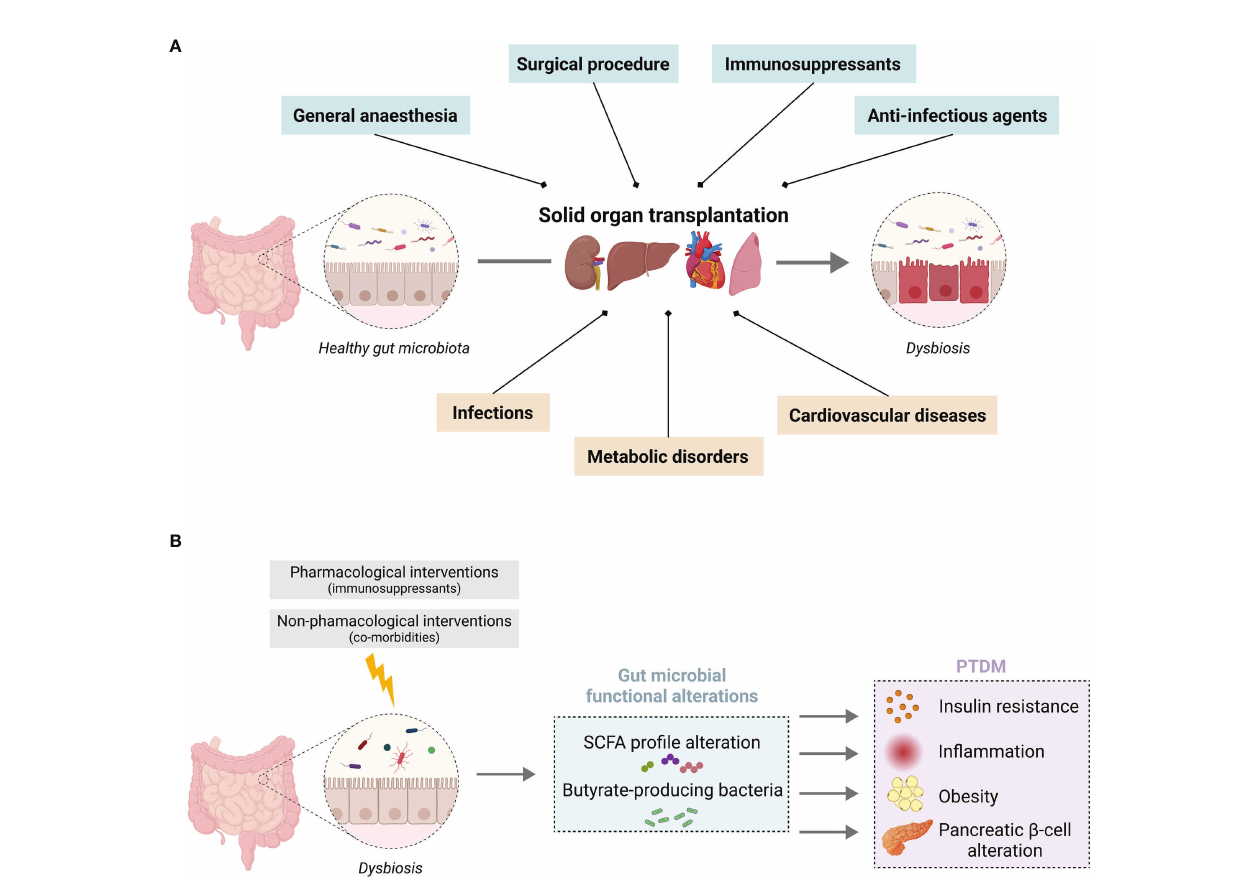
FIGURE 1 | Solid organ transplantation associated pharmacological and non-pharmacological interventions on gut microbiota homeostasis (A) Overview of the impact of SOT on gut microbiota homeostasis associated with (blue) the surgical procedure, anti-infectious prophylaxis, immunosuppressants, and (orange) SOT- related co-morbidities. (B) Putative consequences of an imbalance in SCFA-producing bacteria induced by SOT, which favour the development of PTDM. Illustration created with